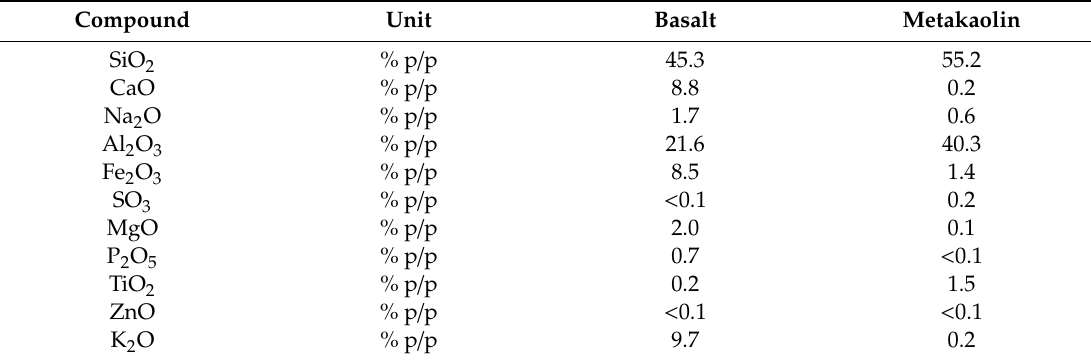
Table 2. Chemical properties of basalt and metakaolin.